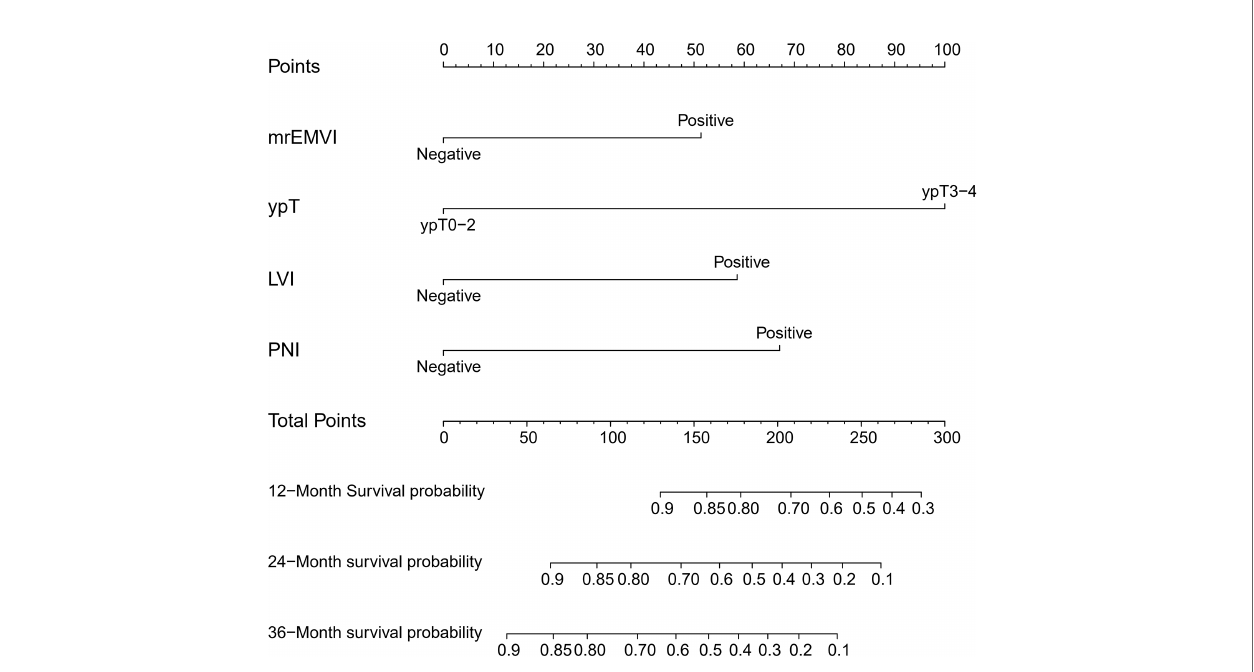
FIGURE 1 | Prognostic nomogram for DFS: The nomogram to predict DFS was developed in the training cohort, and MRI-detected extramural vascular invasion (mrEMVI), ypT, perineural invasion (PNI) and lymphovascular invasion (LVI) were incorporated in the